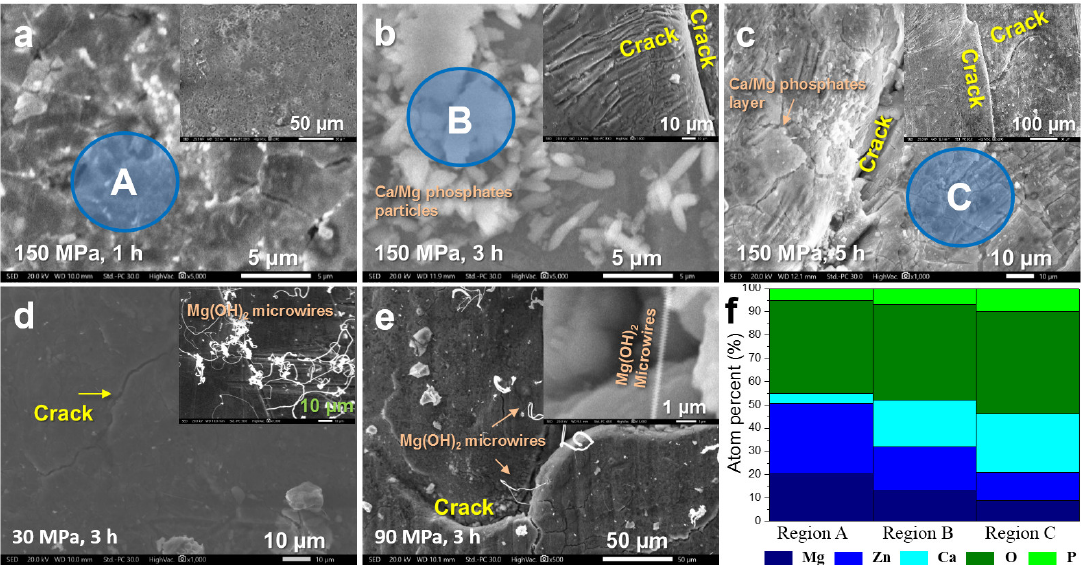
Figure 3. SEM images showing surface morphologies of Mg-Zn-Ca amorphous alloys after constant pressure corrosion: ( a ) Sample 1; ( b ) Sample 2; ( c ) Sample 3; ( d ) Sample 4; ( e ) Sample 5; ( f ) energy-dispersive spectroscopy (EDS) analysis of areas A, B, C in ( a ), ( b ), and ( c ), respectively.